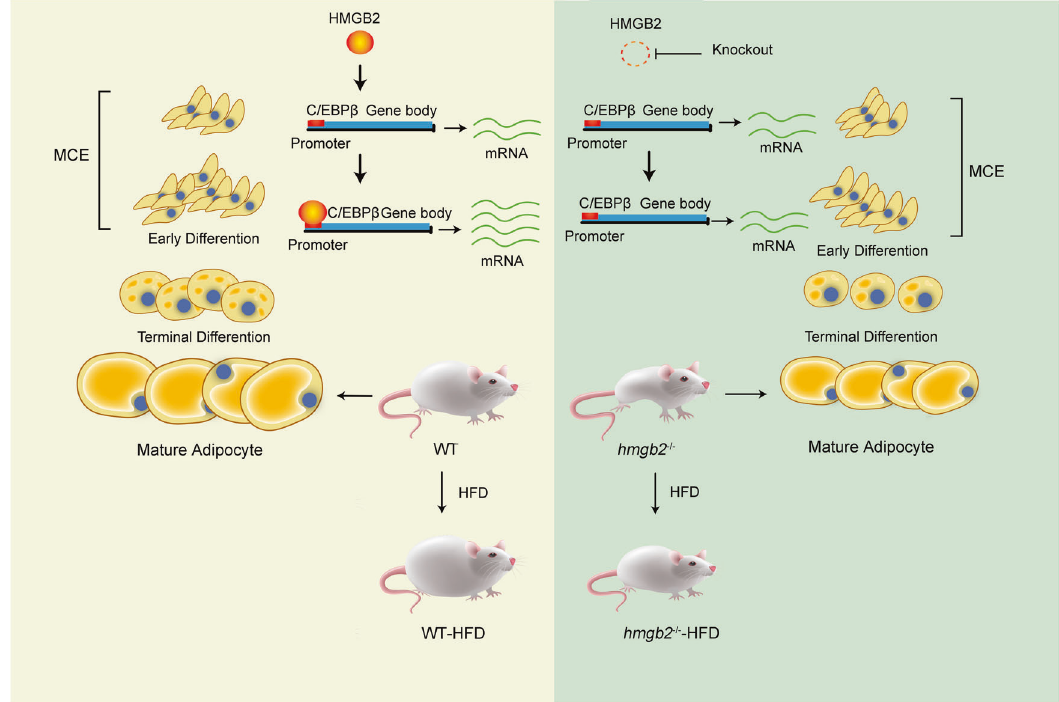
Fig. 7 Regulatory mechanisms of HMGB2 in adipogenesis. HMGB2 binds to the promoter region of C/EBP β in MCE stage to regulate adipogenesis. High-fat diet enhances adipogenic ability of hmgb2 − / − mice but at a lower